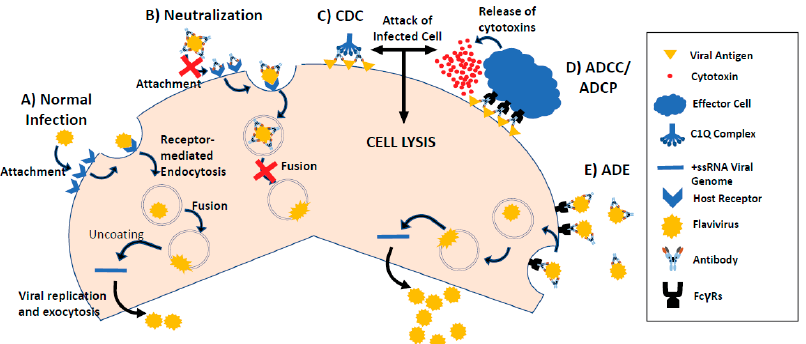
Figure 1. Flavivirus infection cycle and mechanisms of mAb neutralization and enhancement. The entry of flaviviruses into host cells is initiated with the attachment of the E protein with its receptor on the target host cell, which leads to endocytosis of flavivirus virions ( A ). The low pH in the endosome triggers the fusion of the viral envelope with the endosomal membrane, releasing the viral genome to